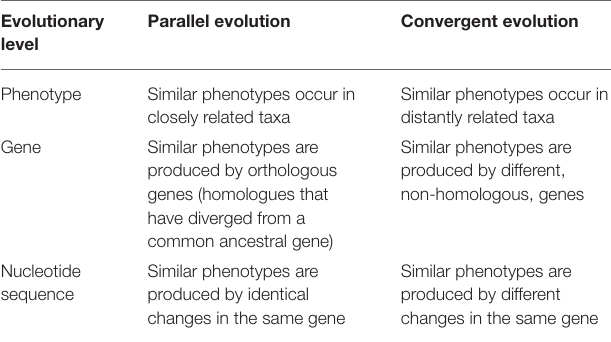
TABLE 1 | Definitions of parallel and convergent evolution at different evolutionary